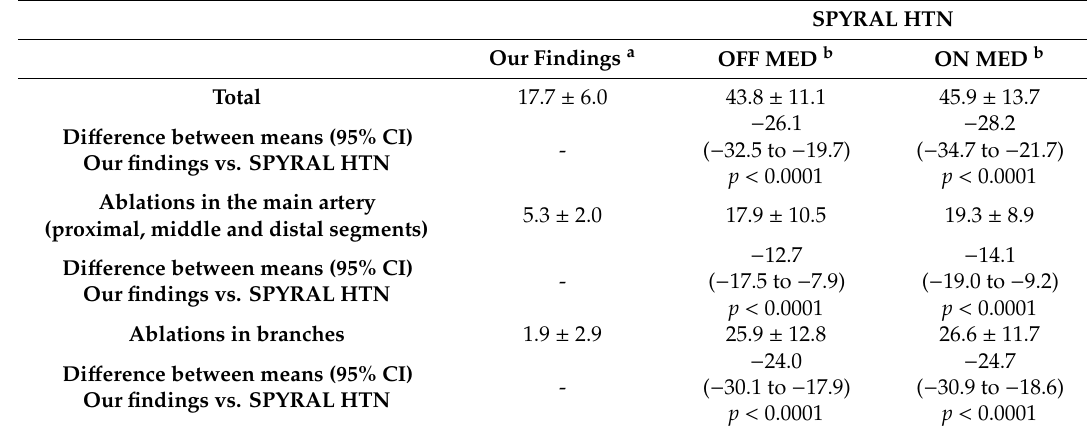
Table 5. Number of ablated spots in renal